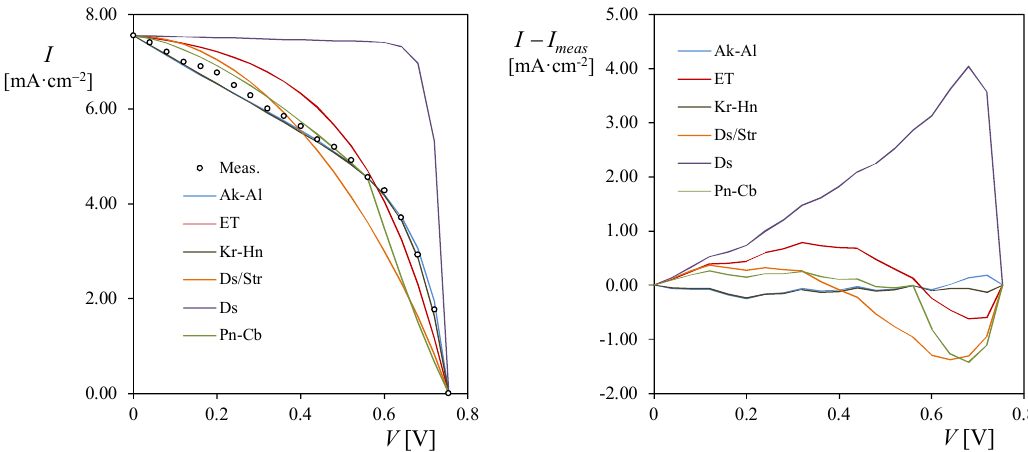
Figure 11. Curves for the explicit models analyzed, fitted to the plastic solar cell data using the